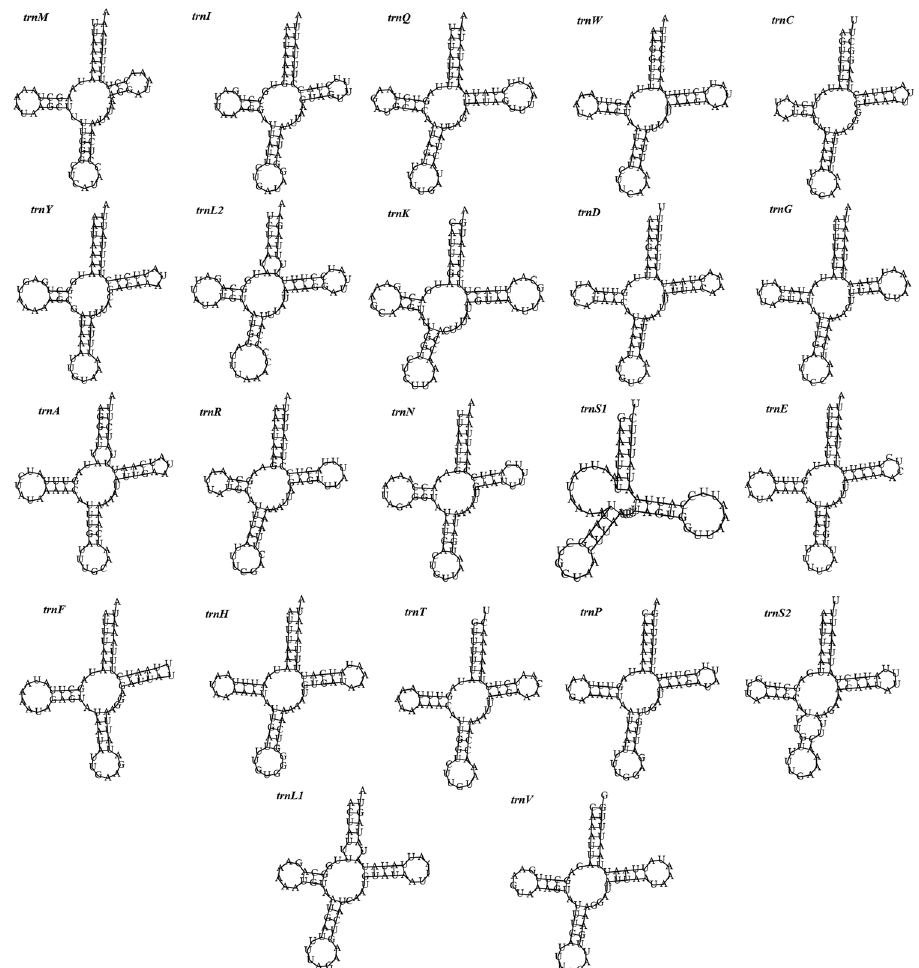
Figure 4. The cloverleaf secondary structure of transfer RNA of T. japonica